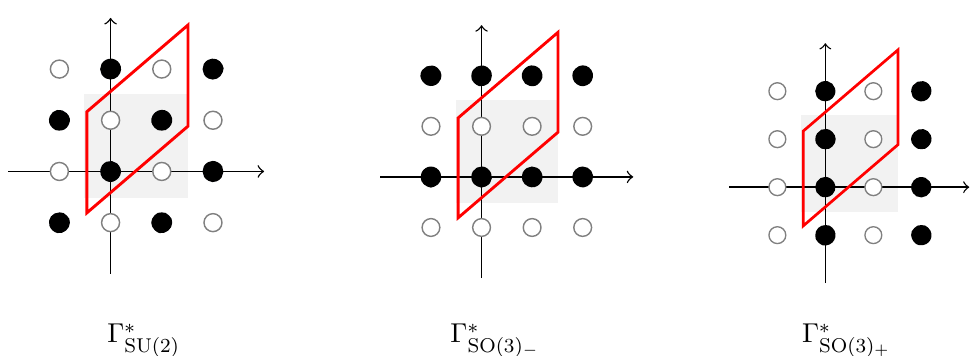
Figure 8 . Here we draw the fundamental cells of the lattices in eq. (4.60). The cartesian grid refers to the ( γ • , γ ◦ ) basis, the γ ◦ direction being the vertical one. In red we draw the fundamental cells identified in